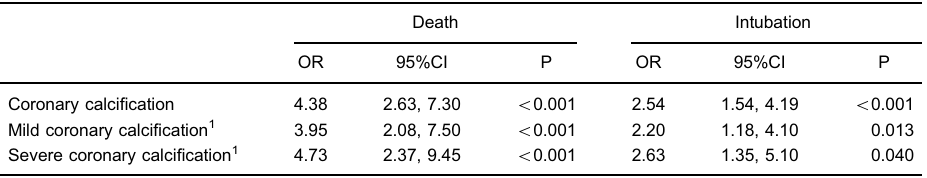
Binary logistic regression; 1 absence of calci fi cation was the reference for analysis.